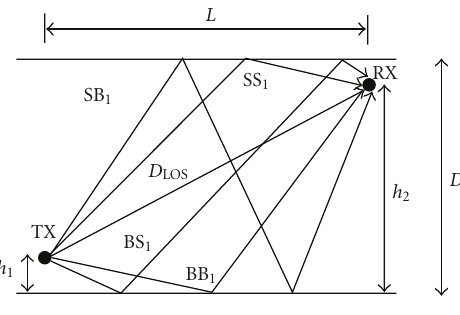
Figure 2: Channel